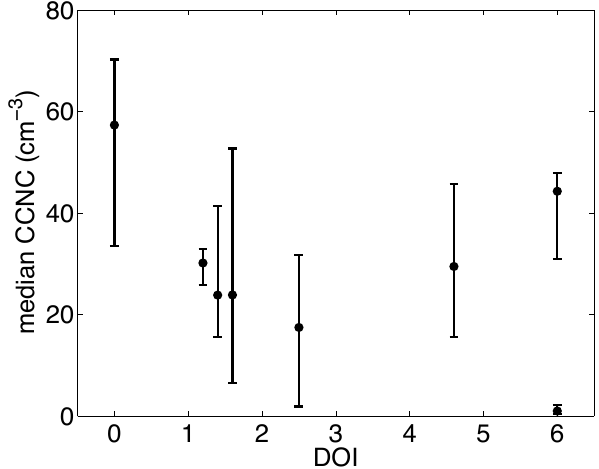
Figure 4. Median (50th percentile) CCNC for the duration of the impactor samples as a function of travel time over ice (DOI, days). Data for all travel times of 5 days and longer have been collected at 6 days. Error bars indicate 25th and 75th